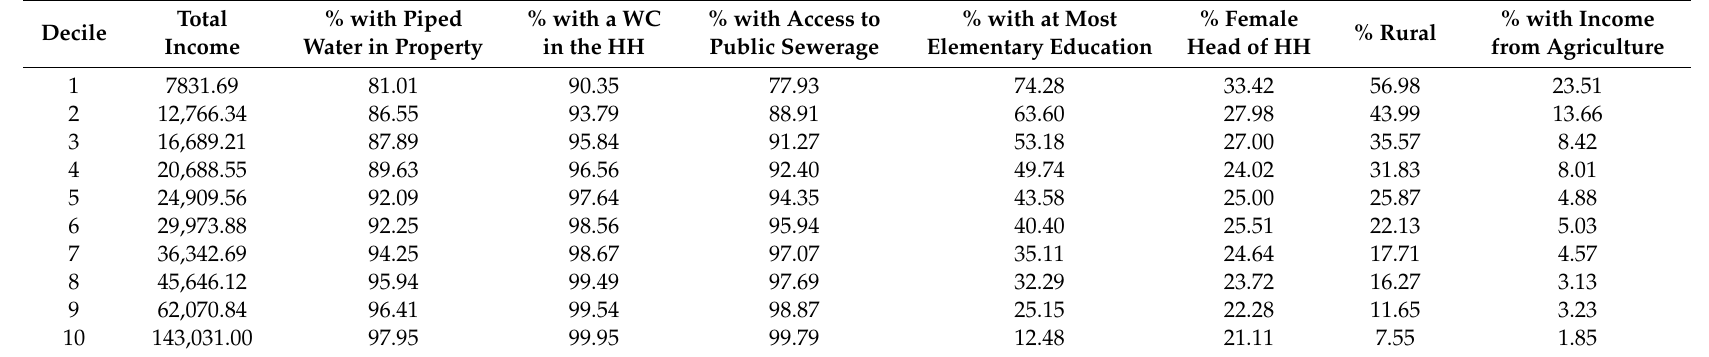
Table 4. Socioeconomic characteristics of Mexican households,